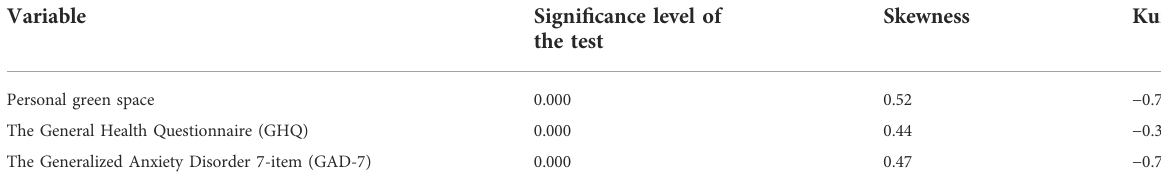
TABLE 6 Evaluation of normality of research variables using the Kolmogorov – Smirnov test. Variable